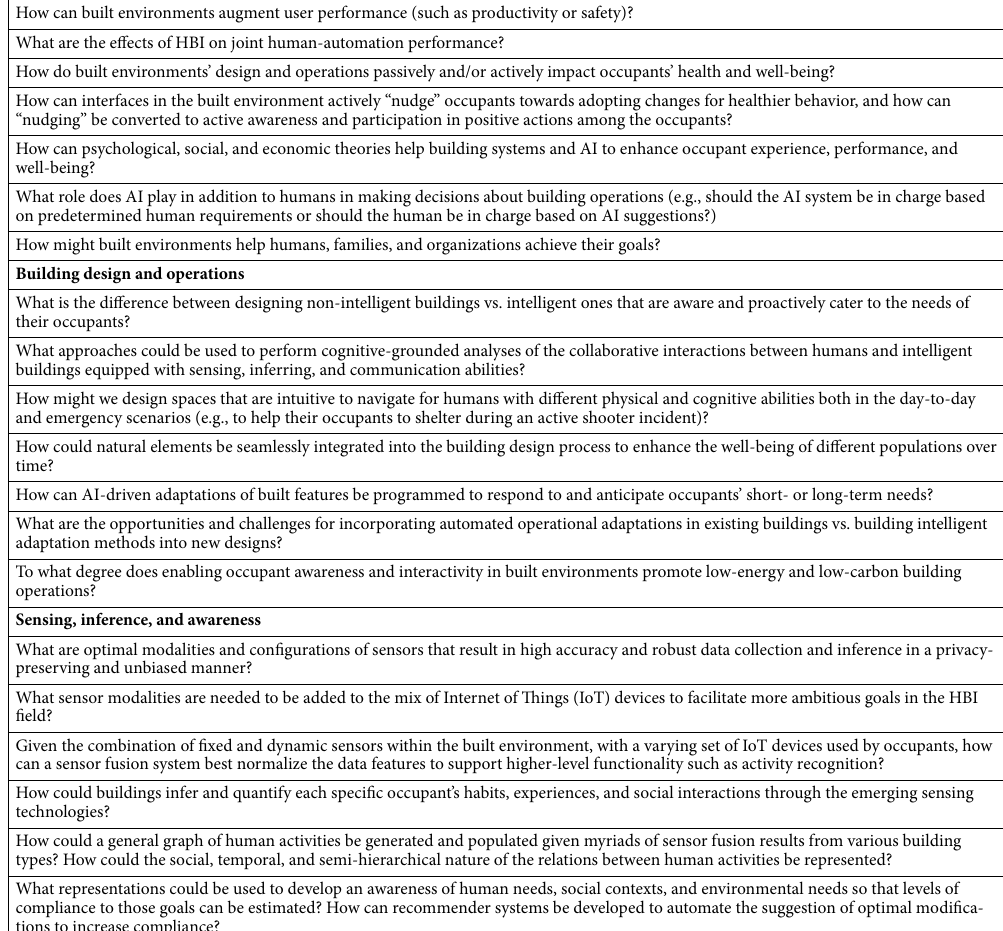
Table 1. Sample research questions related to human, building, and technology aspects of